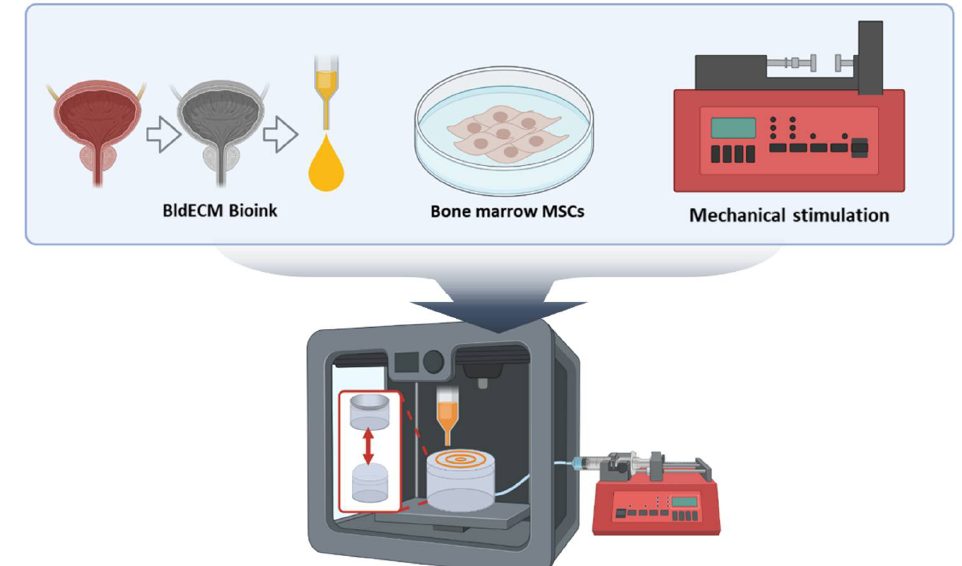
Figure 1. A schematic of the development of the in vitro bladder model system using 3D bioprinting and tissue-specific bioink in conjunction with the physiological stimulation system.